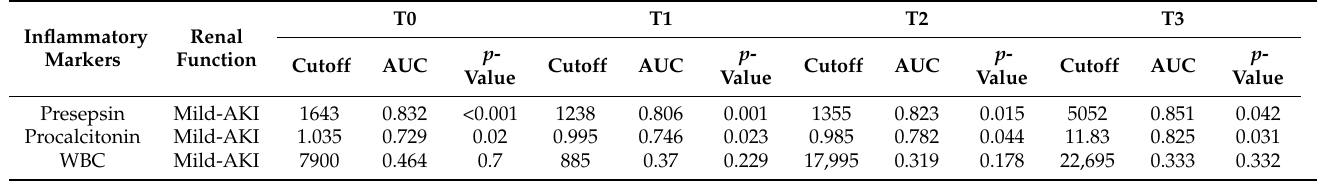
Table 8. Accuracy of inflammatory markers in predicting ICU mortality according to AKI severity, by period. Inflammatory Markers